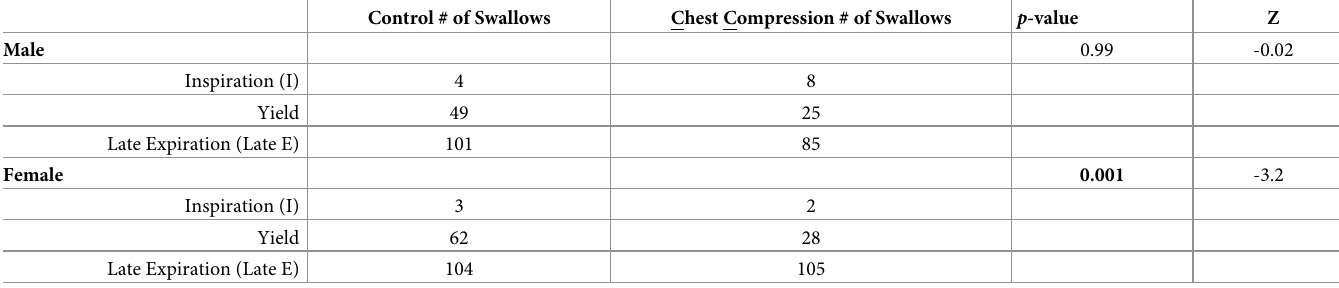
Table 2. Number of swallows during each phase of breathing for control and chest compression conditions for both male and female groups. Control # of Swallows Chest Compression # of Swallows p -value